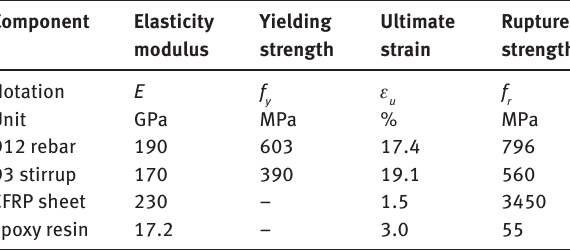
Table 2: Mechanical properties of construction materials Component